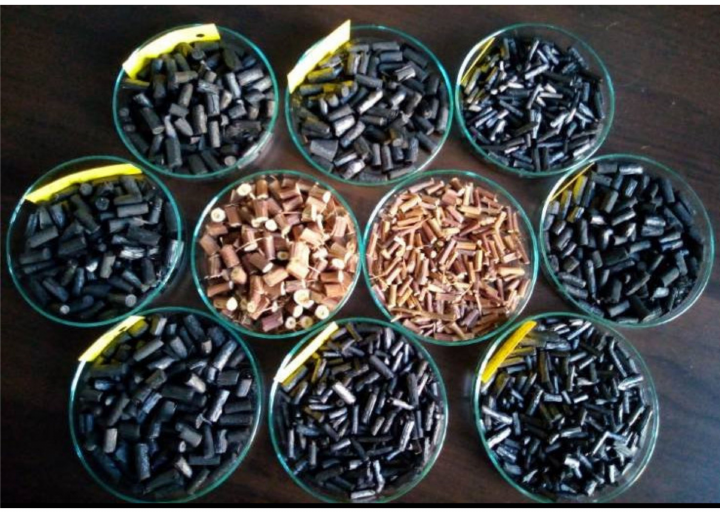
Figure 7. Biochar obtained (exp. 1–8 in Table 1) from coarse and fine chopped vine